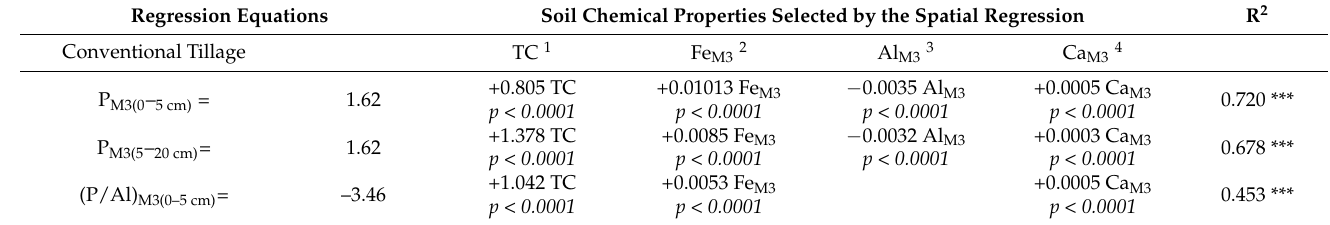
Table 4. Multiple regression equations calculated for soil P indices for two soil layers (0–5 cm and 5–20 cm) in the conventional and no-tillage